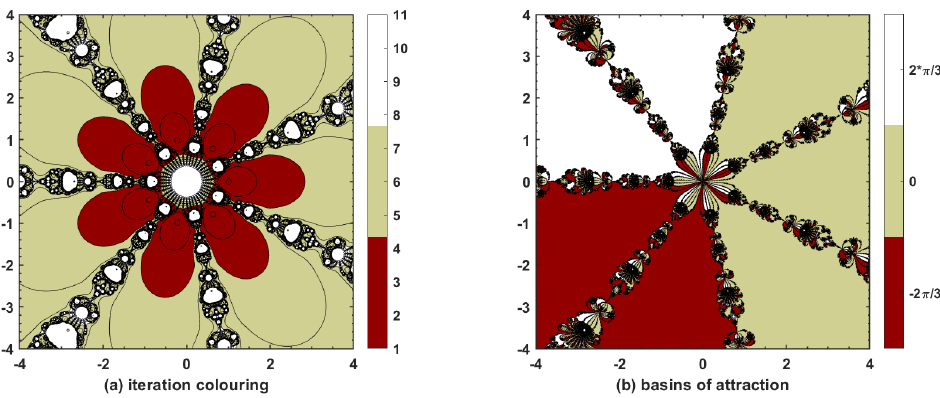
Figure 4. The polynomiographs by the proposed method PM 10 for P 2 ( z )